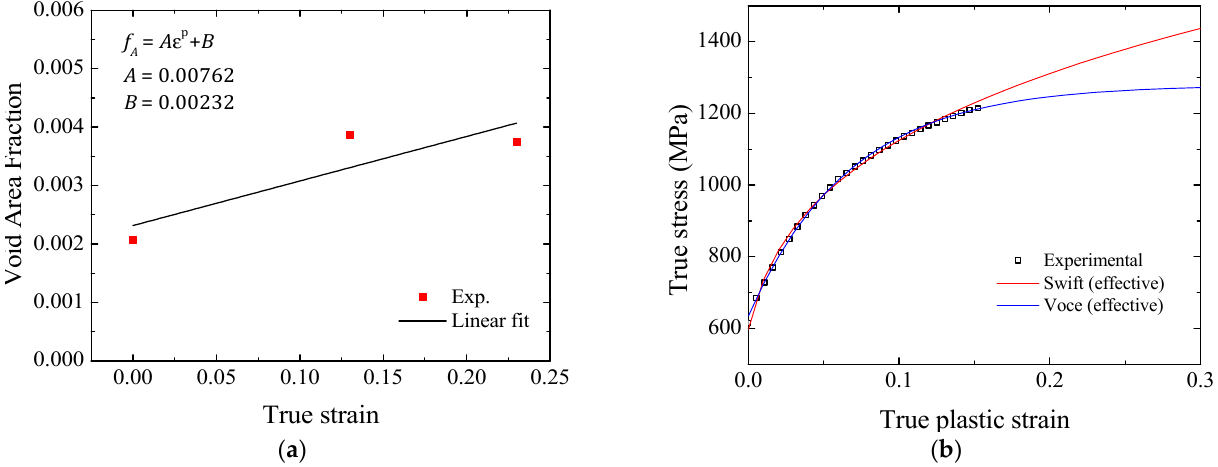
Figure 13. ( a ) Experimental void area fraction as a function of the true longitudinal plastic strain obtained for the CR980XG3 TM steel sheet under uniaxial tension concerning the rolling direction and ( b ) comparison between the experimental true-stress and true plastic-strain data and the predicted work-hardening curves in the rolling direction.